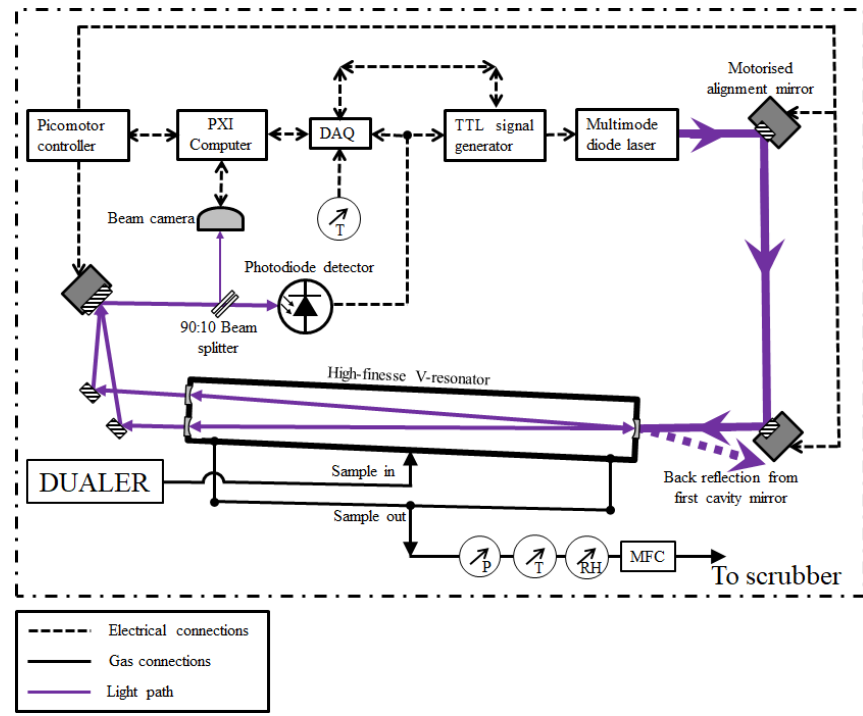
Figure 3. Schematic diagram of a CRDS NO 2 detector in